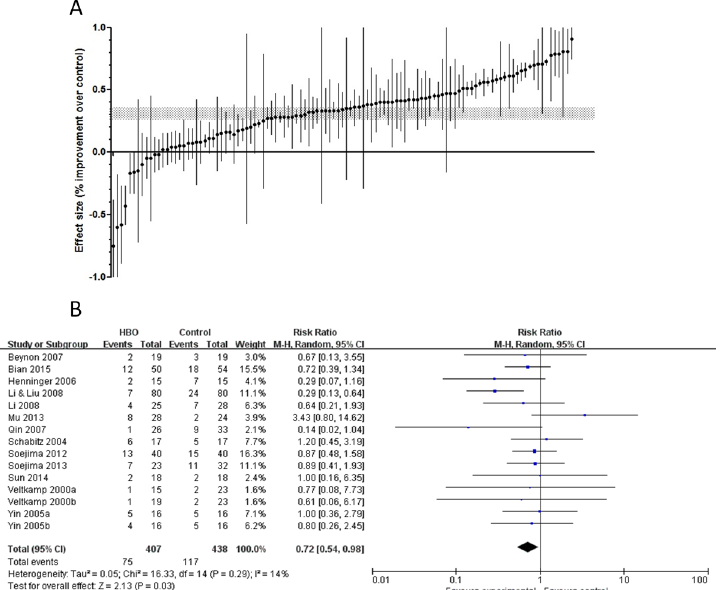
Fig 2. Comparisons ranked according to effect size and comparison of mortality rate. (A) The shaded gray band represents the 95% CI for the global estimate. The vertical error bars represent the 95% CI for individual comparisons. (B) Forest plot of comparison: HBO vs Control, outcome: Mortality.